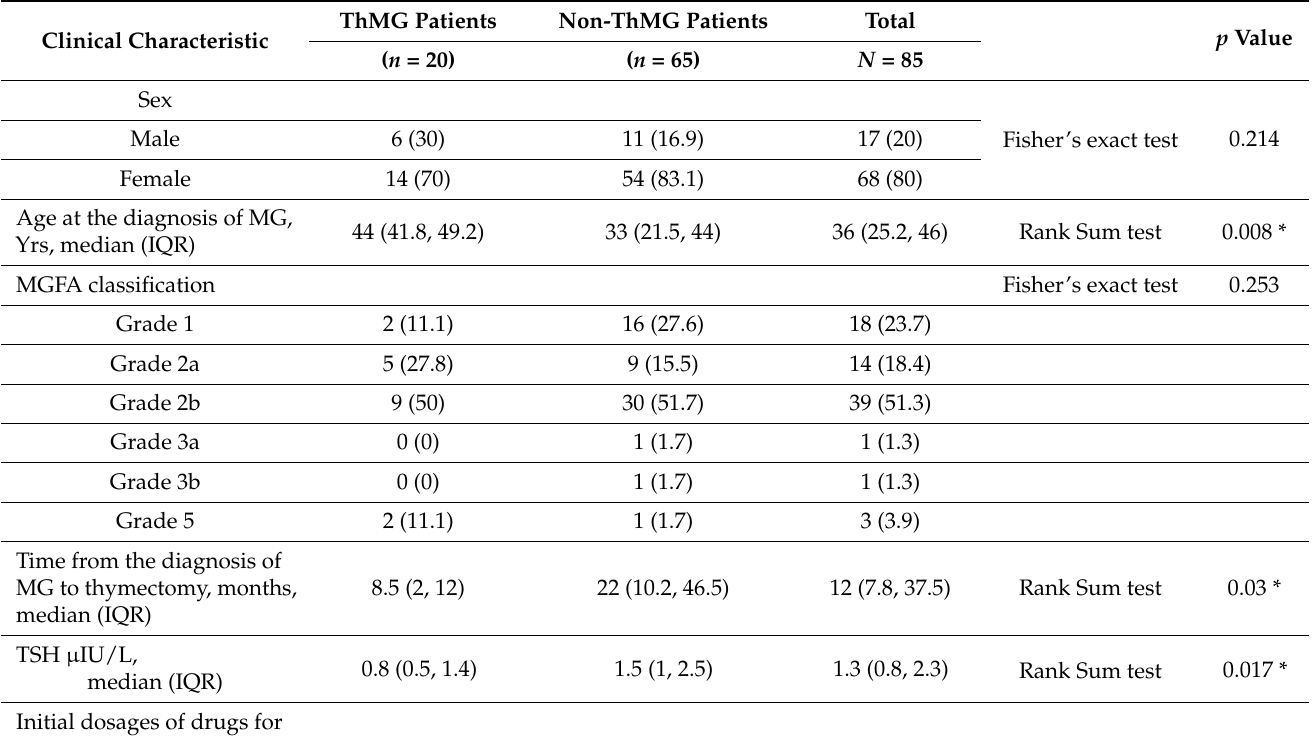
Table 1. Comparison of demographic and clinical characteristics between ThMG and non-ThMG patients before the